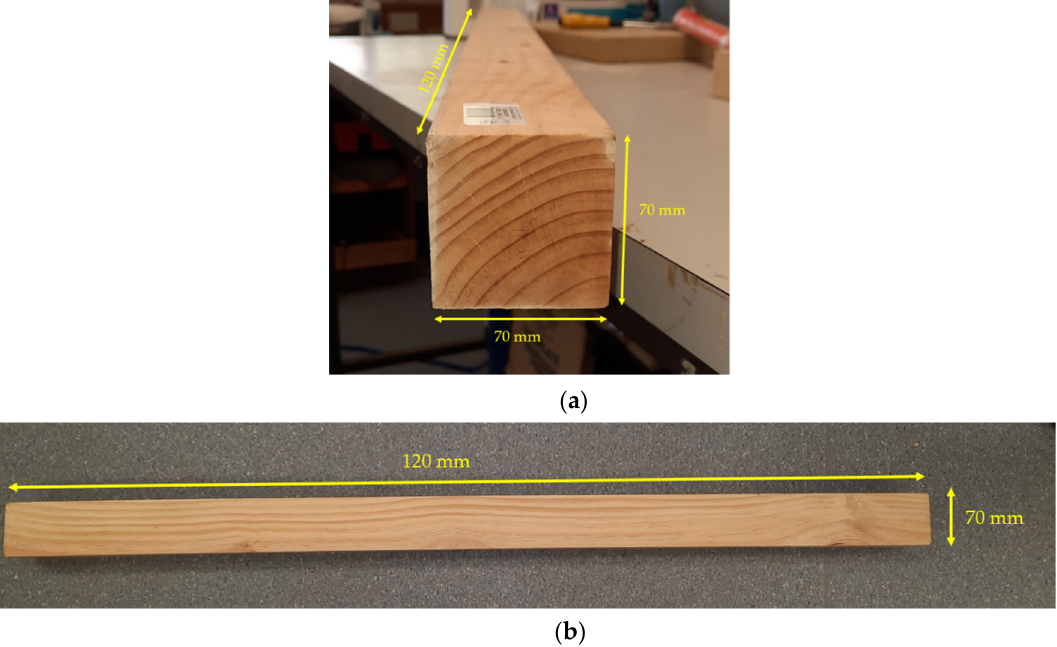
Figure 2. Wood sample: ( a ) the end face of the pine wood sample (70 mm × 70 mm) (Pinus radiata); ( b ) wood sample side view (120 mm × 70